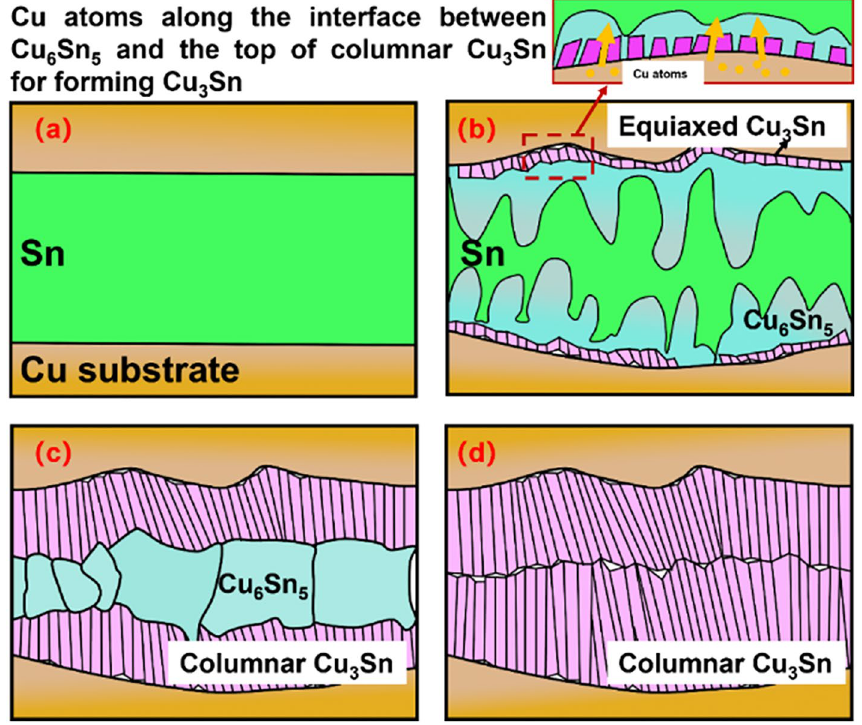
Figure 1. Schematic diagram of the structure of Cu 3 Sn solder joints prepared by the conventional TLP method ( a ) Cu/Sn/Cu sandwich structure, ( b ) Cu atoms along the interface between Cu 6 Sn 5 and the top of columnar Cu 3 Sn for forming Cu 3 Sn, ( c ) Cu 3 Sn becomes longer, ( d ) Cu 3 Sn grains grow along the long axis of the columnar grains. When the opposite Cu 3 Sn grains touch each other, the grains stop growing, leaving a Cu 3 Sn boundary line in the middle of the